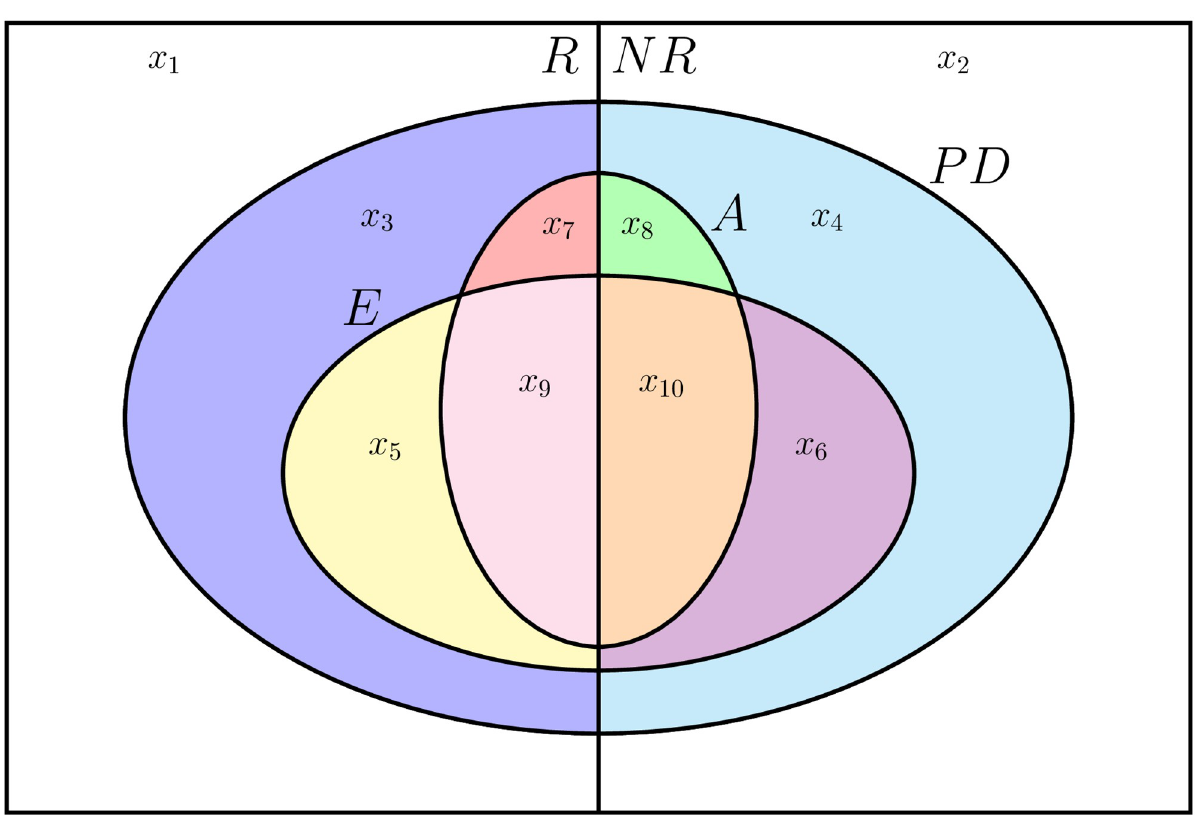
Fig 1. Potential donor deaths, eligible deaths, donor authorization and donor